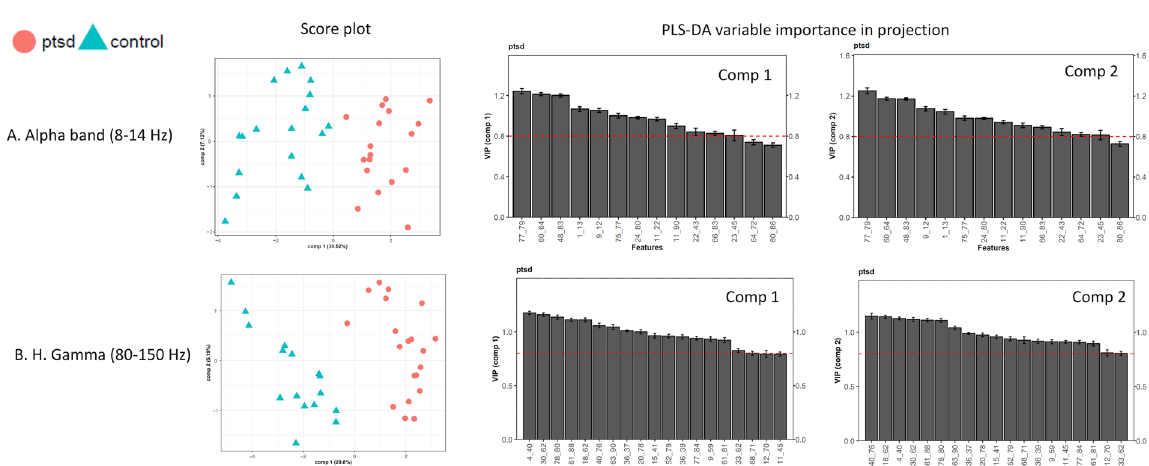
Figure 5. Score plots and VIP plots showing PLS-DA results. Left column: PLS-DA score plots showing the supervised clustering pattern on both components upon PLS-DA modelling using the CV-SVM-rRF-FS selected edges; right column: PLS-DA VIP scores for both model components for all the CV-SVM-rRF-FS selected edges, with the horizontal dashed line indicating the importance threshold (0.8), and the codes on the x-axis representing the edges. ( A ) Alpha band and ( B ) H. Gamma